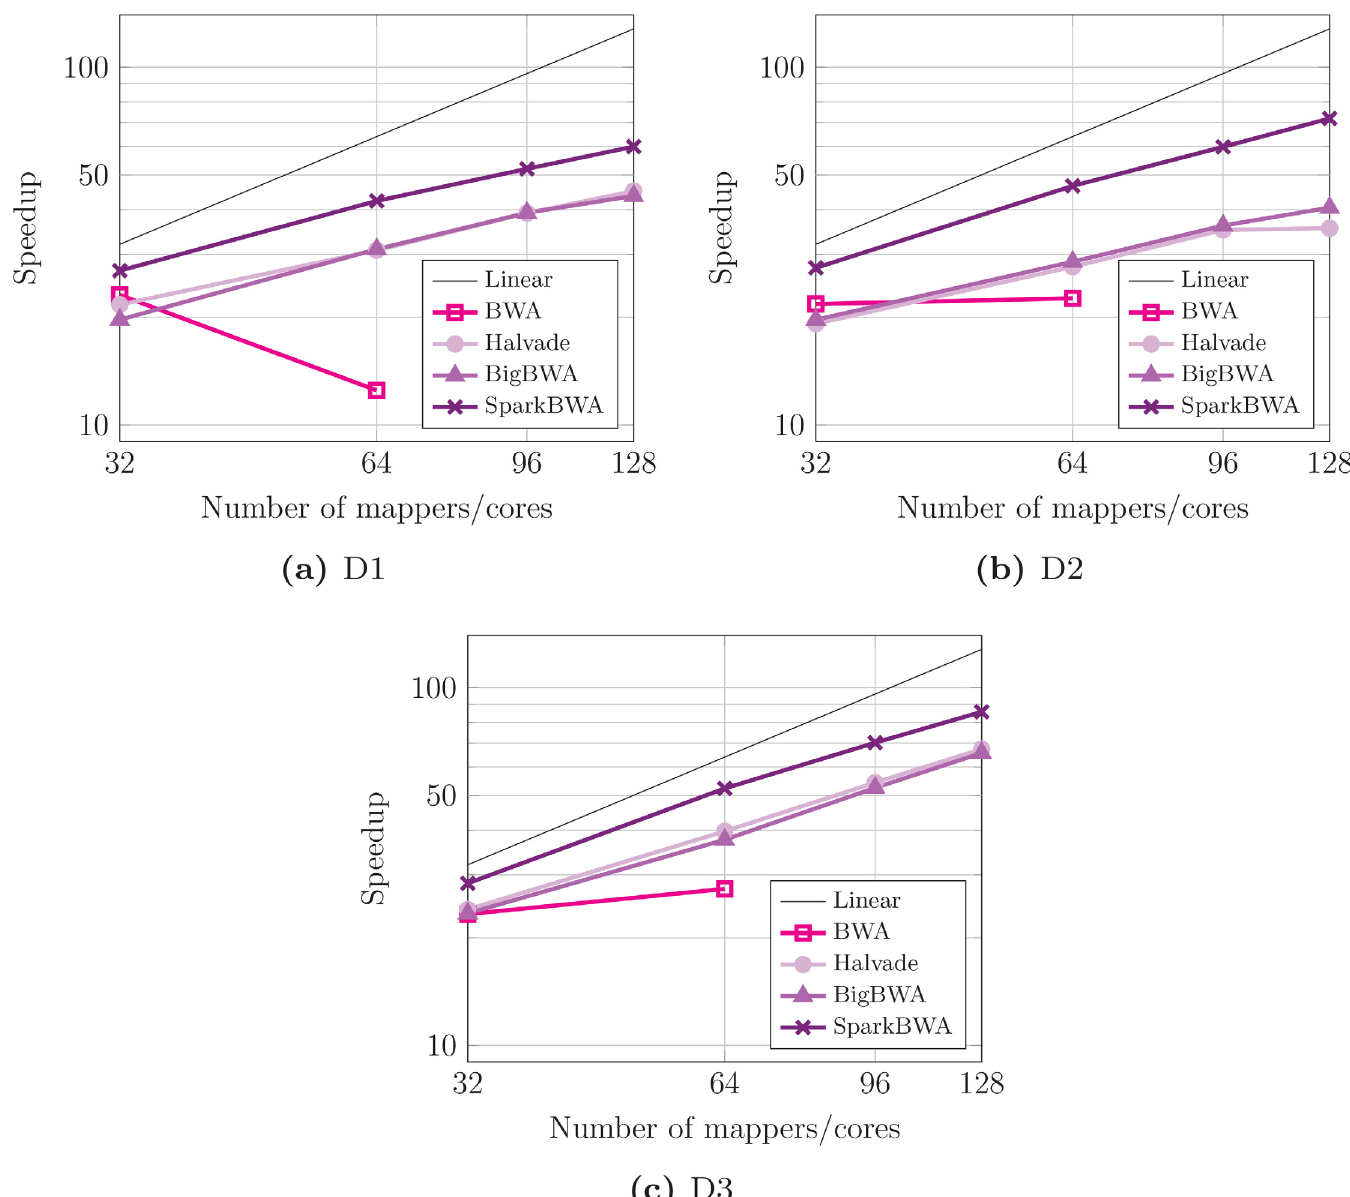
Fig 12. Speedup considering several BWA-based aligners running the BWA-MEM algorithm (axes are in log